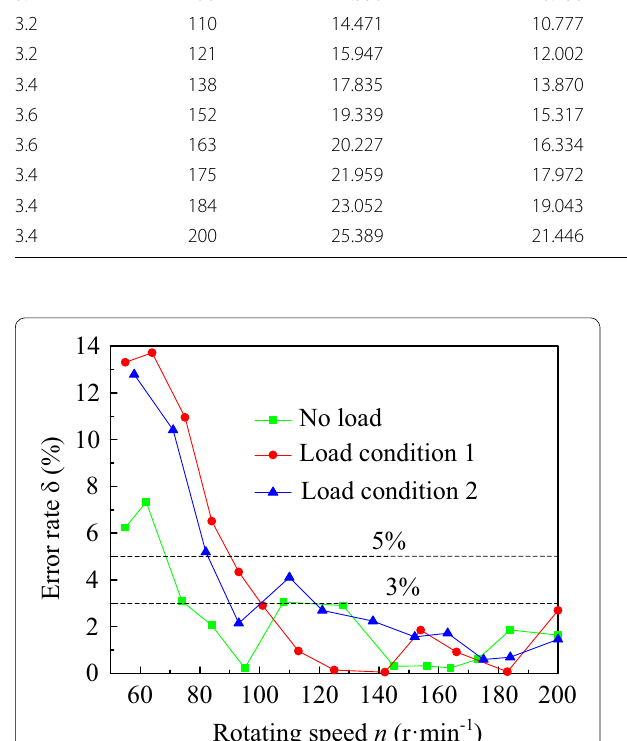
Figure 20 Test error rate curves of seawater hydraulic motor under different load